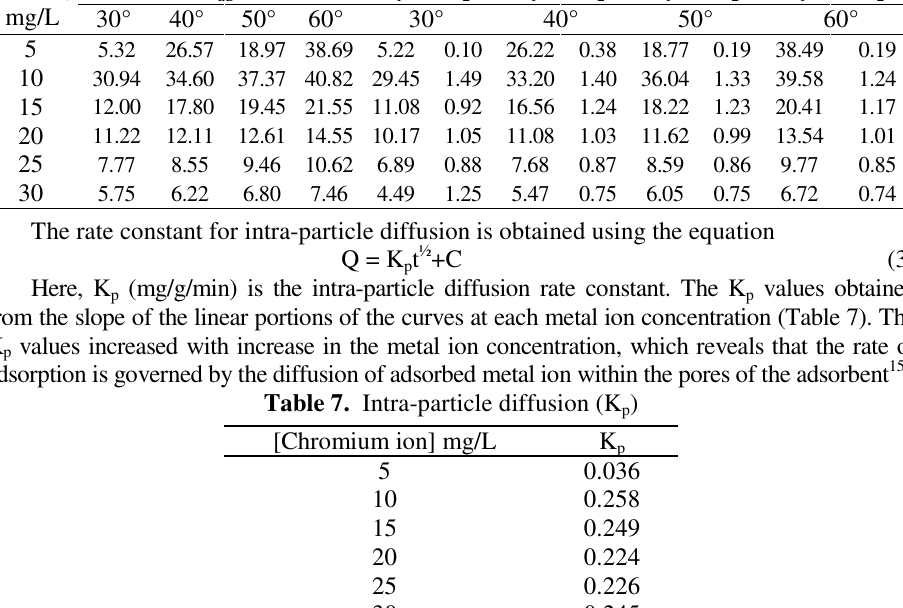
Table 6. Rate constants for the adsorption of metal ions (10 3 k